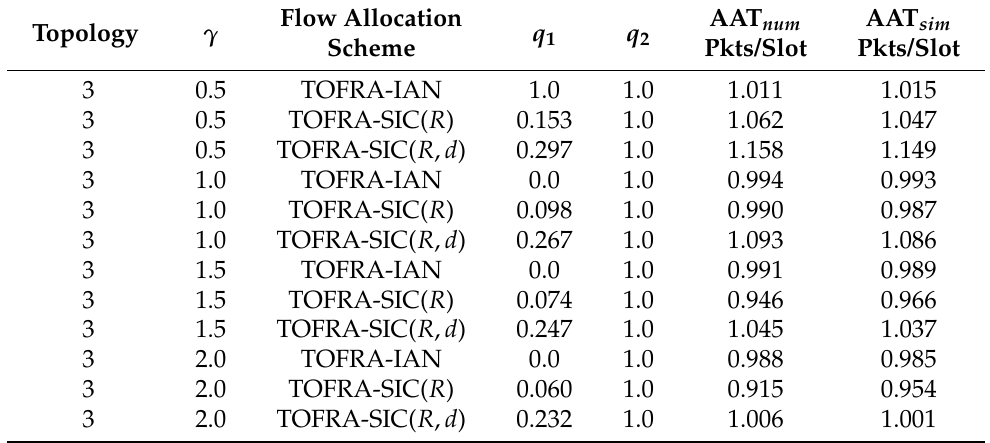
Table 5. Simulation vs. numerical results for the AAT achieved by each TOFRA variant. Topology 3.